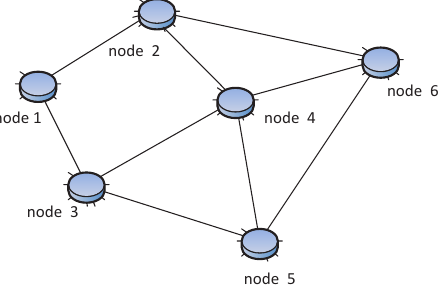
Figure 8. Disjoint paths and brained paths. (1, 2, 6) and (1, 3, 5, 6) are disjoint-paths. (1, 3, 4, 6) and (1, 3, 5, 6) are brained